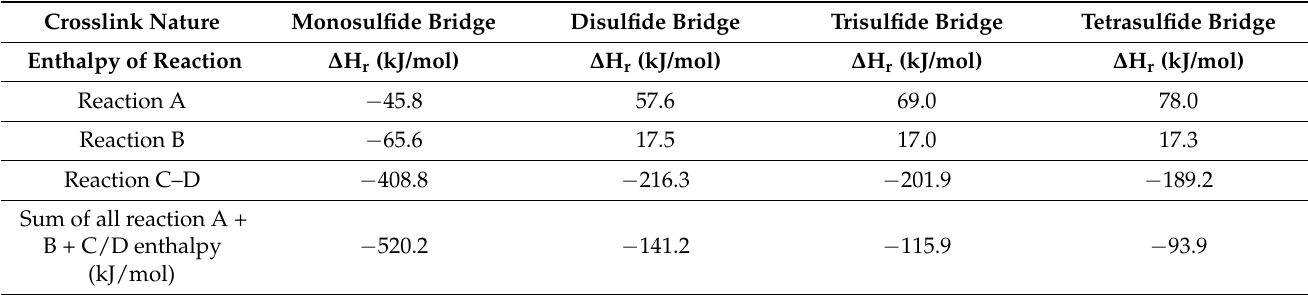
Table 5. Enthalpy of reaction for the formation of the sulfur crosslinks between rubber adjacent